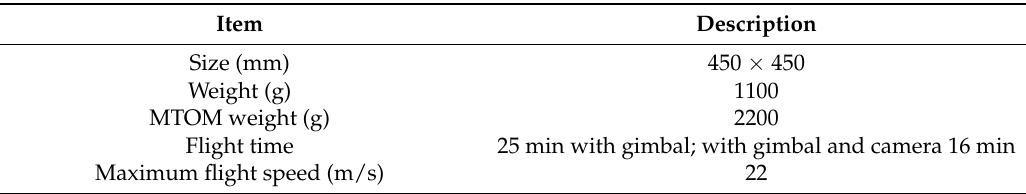
Table 2. Technical specification of UAV.